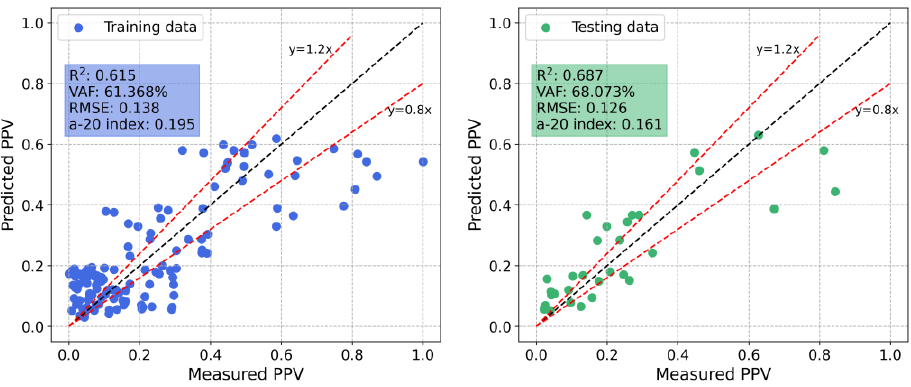
Figure 9. Predicted PPV values by the ANN model VS measured ones.